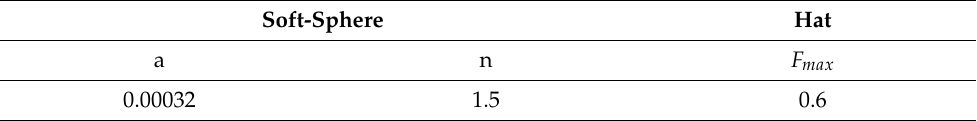
Table A3. Simulation parameters, conservative interaction in the particle suspension.